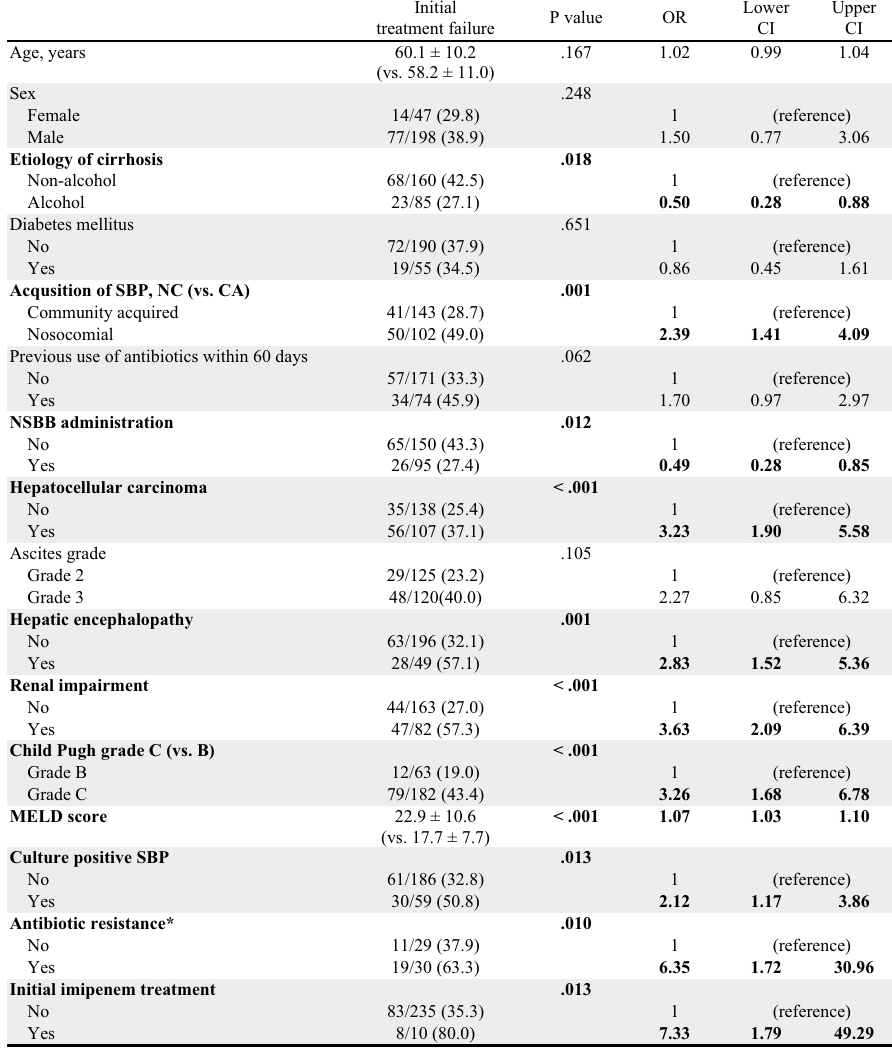
Table 3. Factors associated with initial treatment failure (Univariate analysis). CRP C-reactive protein, GI Gasointestinal, MELD Model for end stage liver disease, PMNLs Polymorphonuclear leukocytes, SBP Spontaneous bacterial peritonitis, WBC White blood cells. Antibiotic resistance* includes resistance to one of cefotaxime, ciprofloxacin, vancomycin, and ESBL( +). Significant values are in